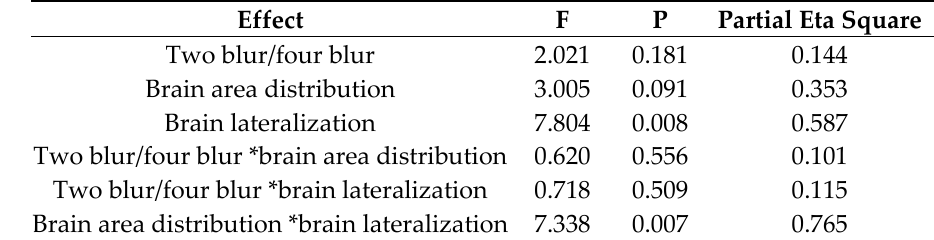
Table 2. The results of 0~200 ms in the experimental group.